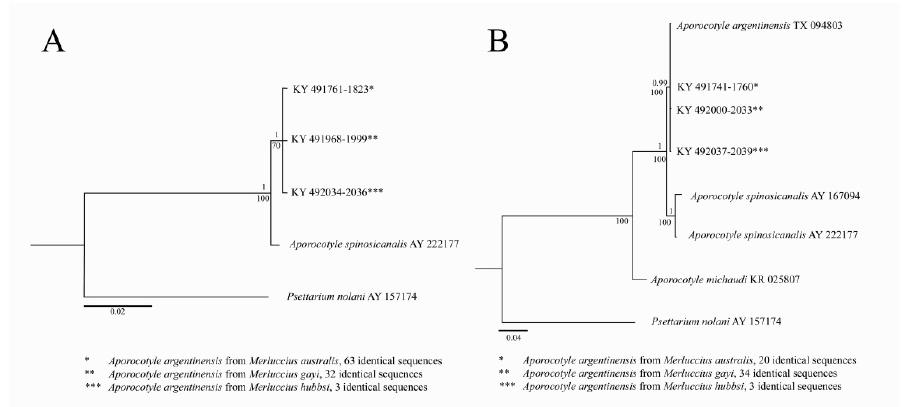
Figure 2. Molecular phylogeny of Aporocotyle spp. parasitizing Merluccius spp. from South America based on the SSU rDNA gene ( A ) and LSU rDNA gene ( B ). BI support value above and ML support below the node.